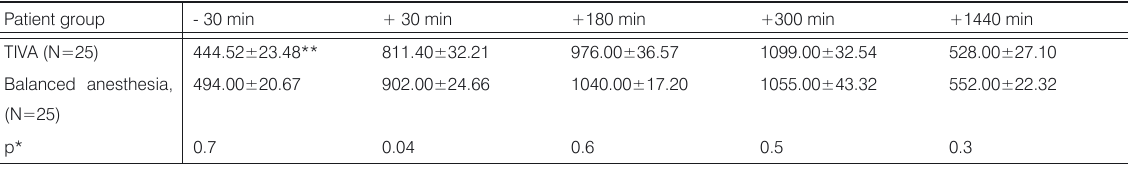
TIVA, total intravenous anestesia * Mann-Whitney test ** X±SE (for all data in the table) Table 2. Circulating prolactin levels (mU/L) in patients treated under TIVA with propofol-fentanyl in comparison to those in patients treated under balanced anesthesia with isoflurane-fentanyl at different time points.